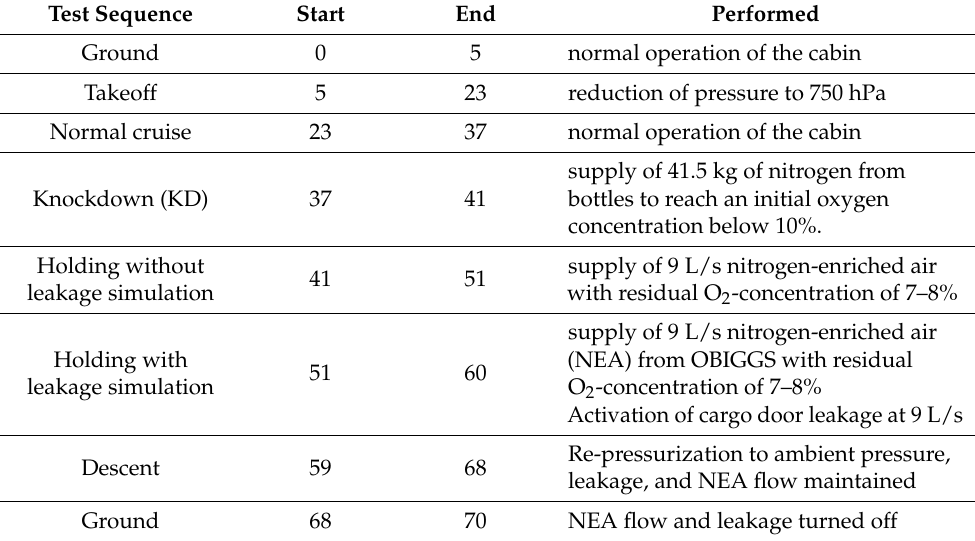
Table 1. Performed test